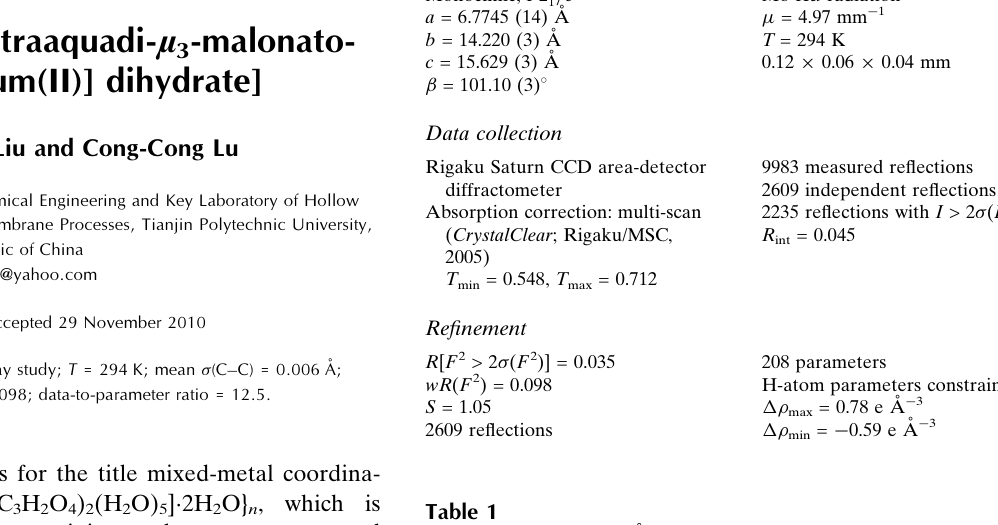
Selected bond lengths (A˚ ).